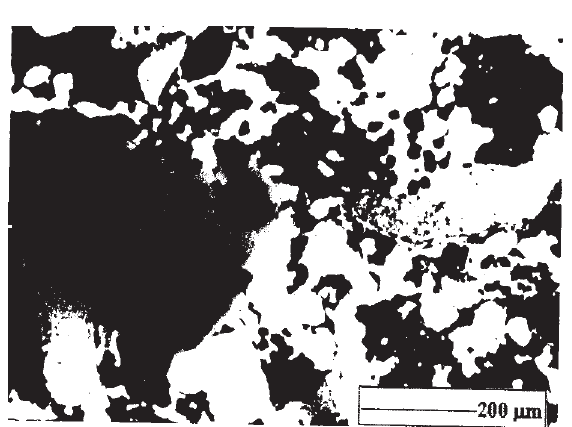
Figura 5. Atividade biológica e contextura matricial porfírica no horizonte BA do perfil com 25 anos de cultivo (1/2